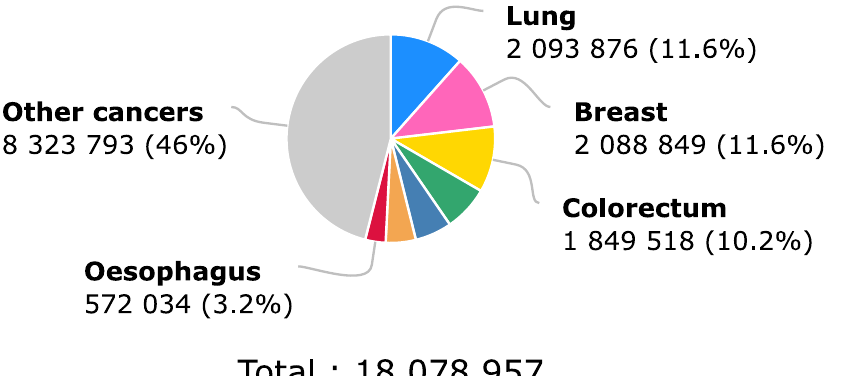
Figure 1. Estimated number of new cancer cases in 2018 worldwide for both sexes and all ages. Here, 33% of the incidence of cancer in the world population during 2018 corresponded to lung, breast and colorectal cancer, which was in third place, which is why the impact of better early diagnosis methods would help a significant portion of the population. Recovered from [1].